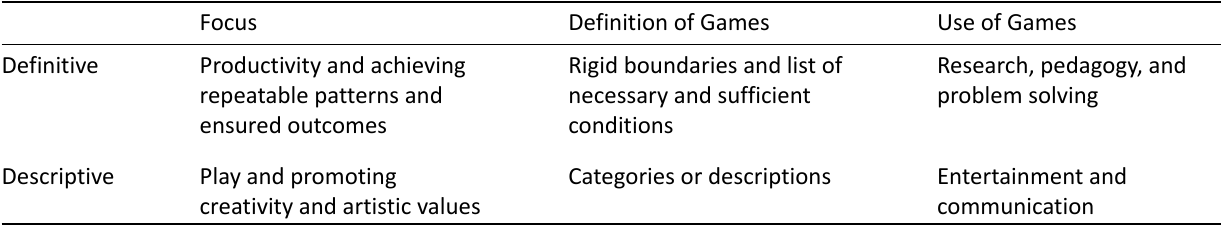
Table 1. Differences between definitive and descriptive approaches to defining